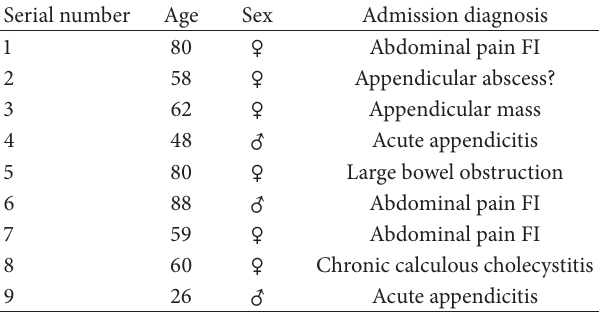
Table 1: Patients’ demographics and admission diagnosis.